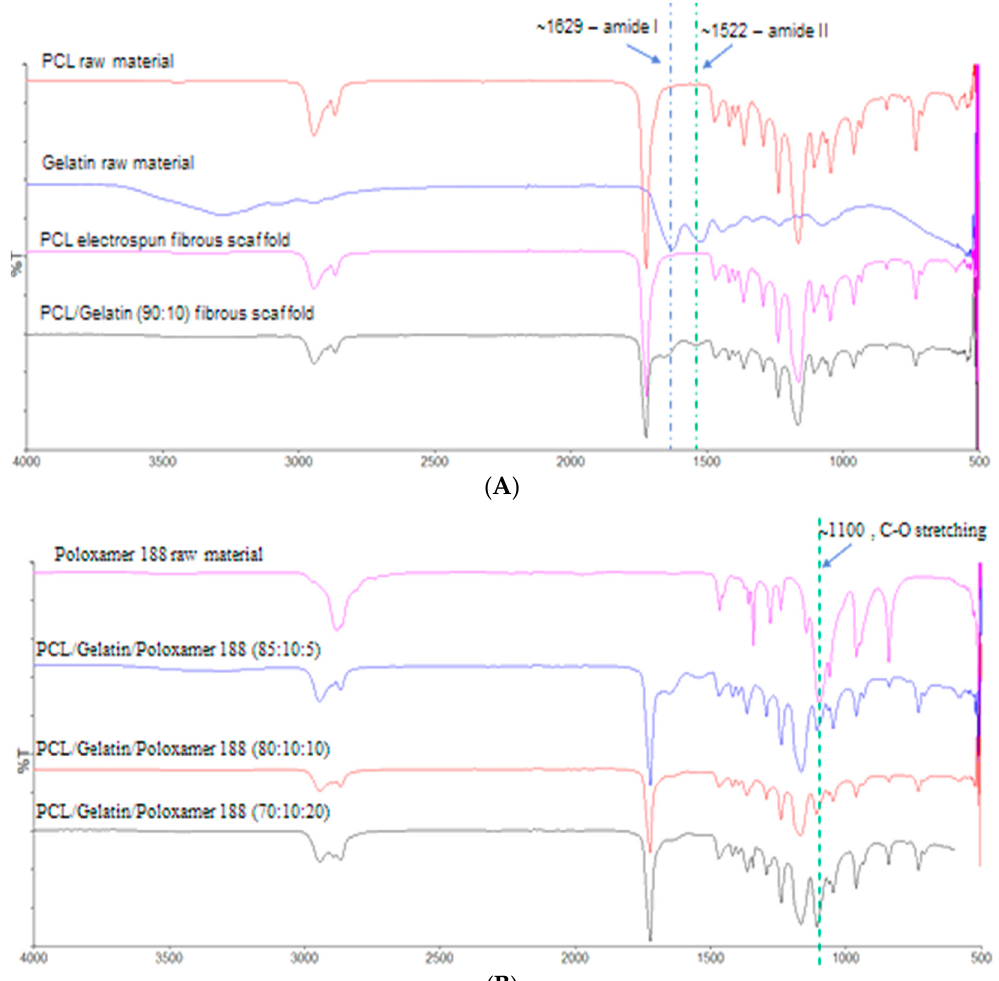
Figure 7. ( A ) Attenuated total reflection Fourier transform infrared spectroscopy (ATR-FTIR) spectra of PCL and PCL/gelatin composite electrospun nanofibers compared with the PCL and gelatin pure raw materials. ( B ) ATR-FTIR spectra of three different concentrations of PCL/Gelatin/P188 composite electrospun nanofibers compared with the pure raw material of P188 (were %T is the transmission percentage).